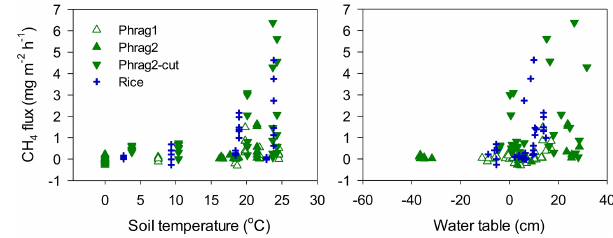
Figure 3. Relationship between CH 4 emission rates and (a) soil temperature, and (b) water table, in two Phragmites australis wet- lands and a rice paddy in the Liaohe Delta, Northeast China. Data points after cutting the vegetation at Phrag2 are represented by downward triangles (Phrag2-cut). Measurements were done from April to November 2012.